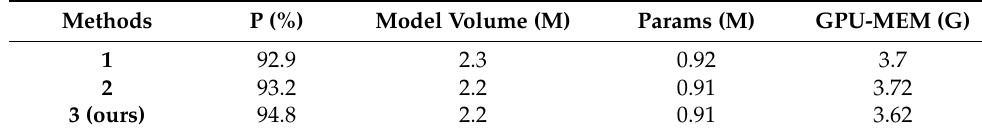
Table 12. The ablation study on the SSDD dataset.